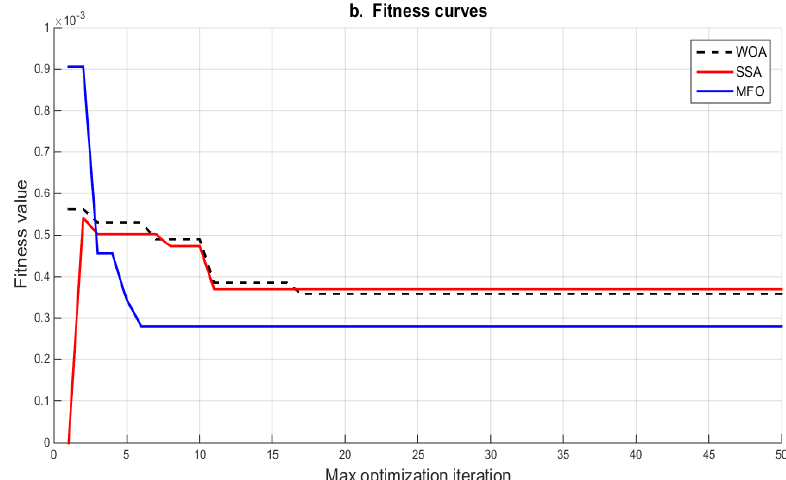
Figure 6. The number of rounds versus fitness function within WOA, MFO and SSA.